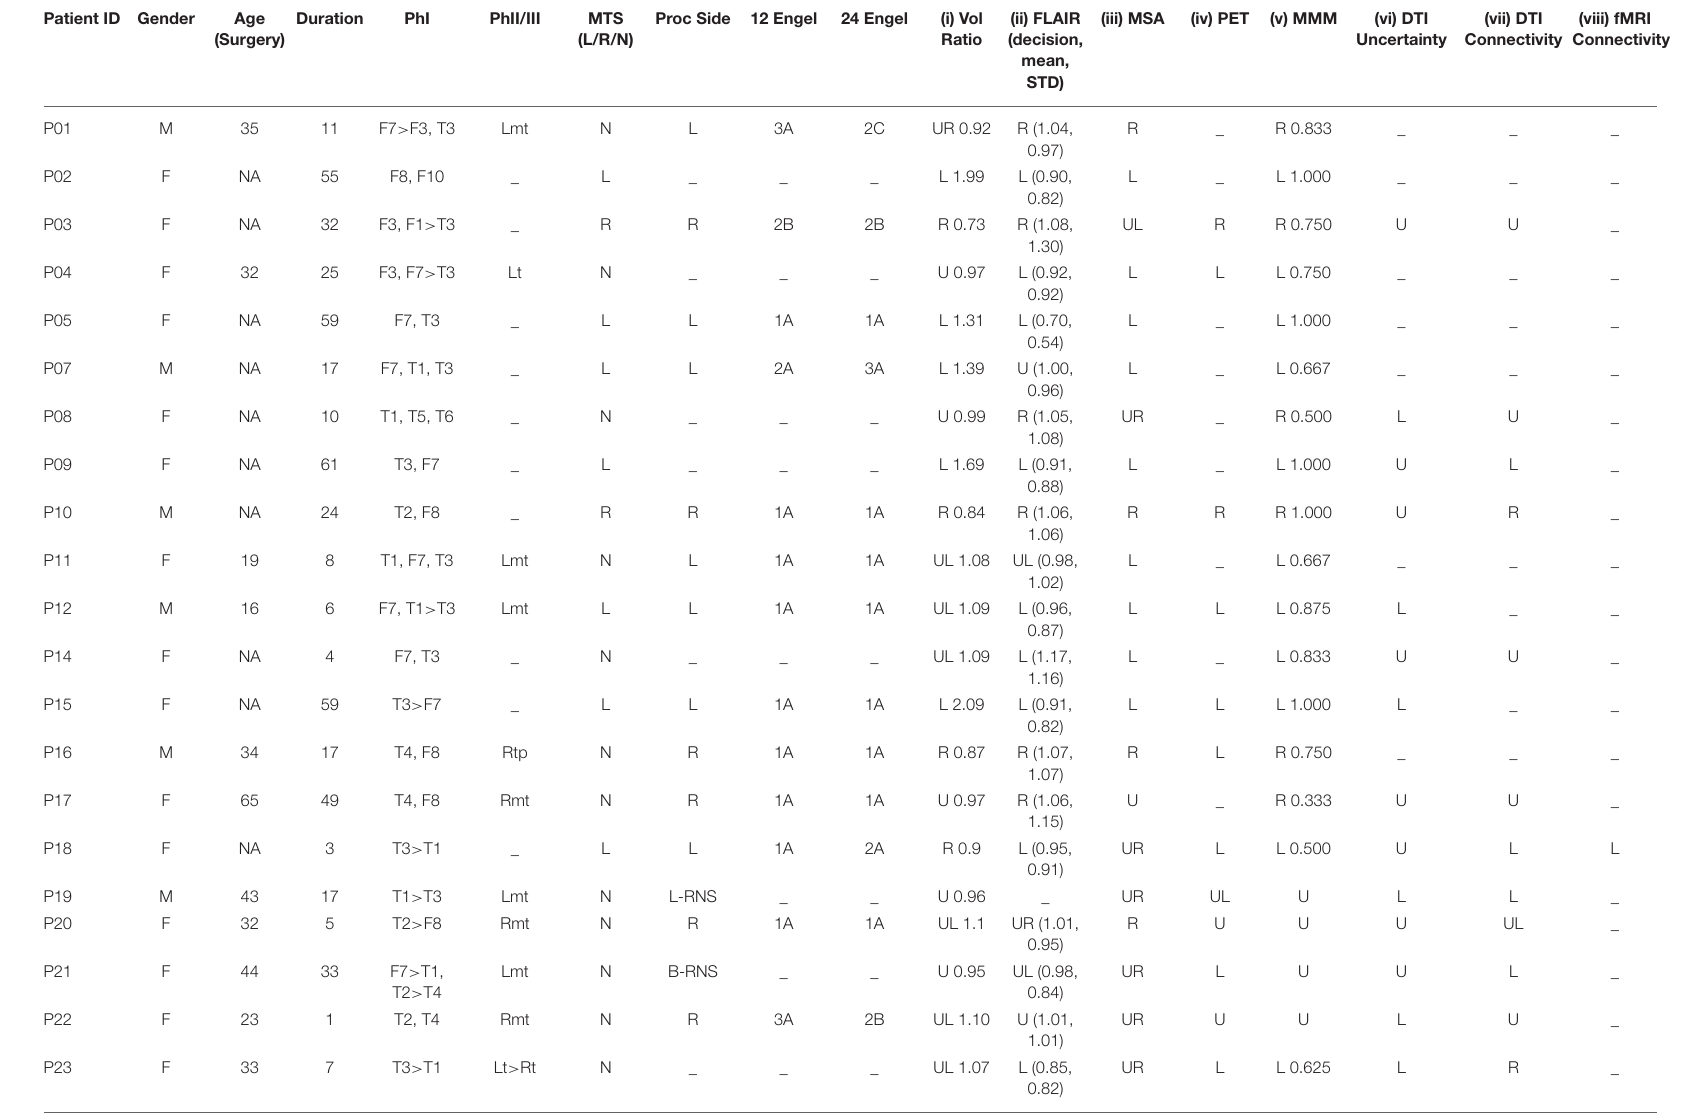
TABLE 1 | Quantitative neuroimaging and clinical attributes of